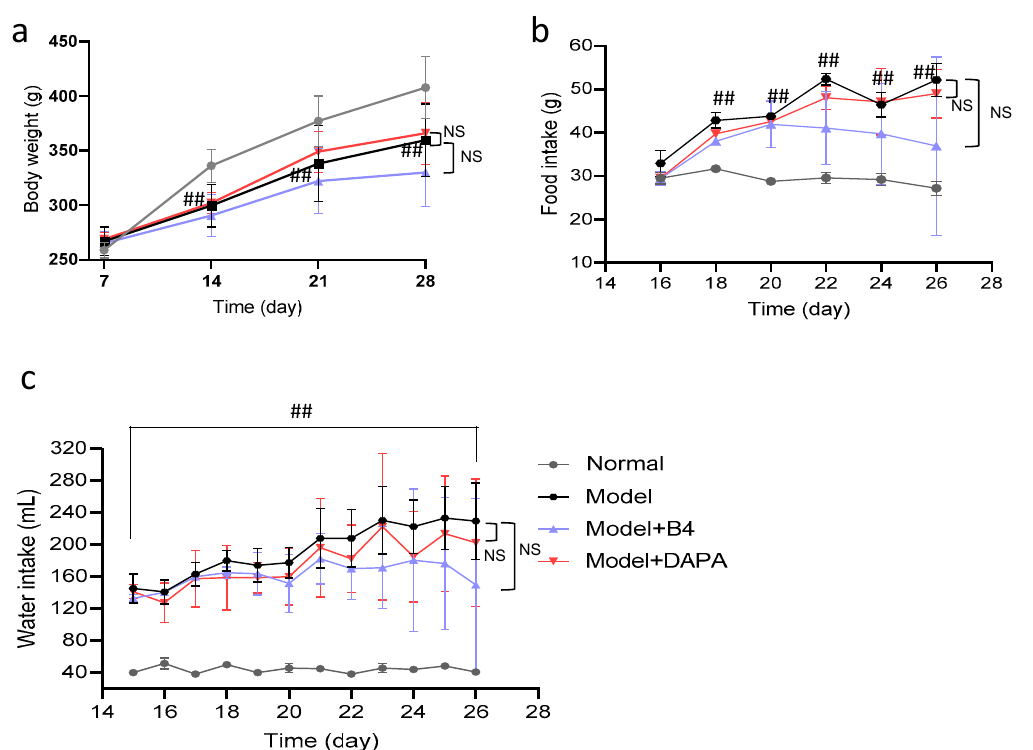
Figure 2. Effect of AB4 on body weight, food intake, and water intake of hyperglycemia rats. ( a ) body weight; ( b ) food intake; ( c ) water intake. ## p < 0.01 vs. normal group. NS: no significance.